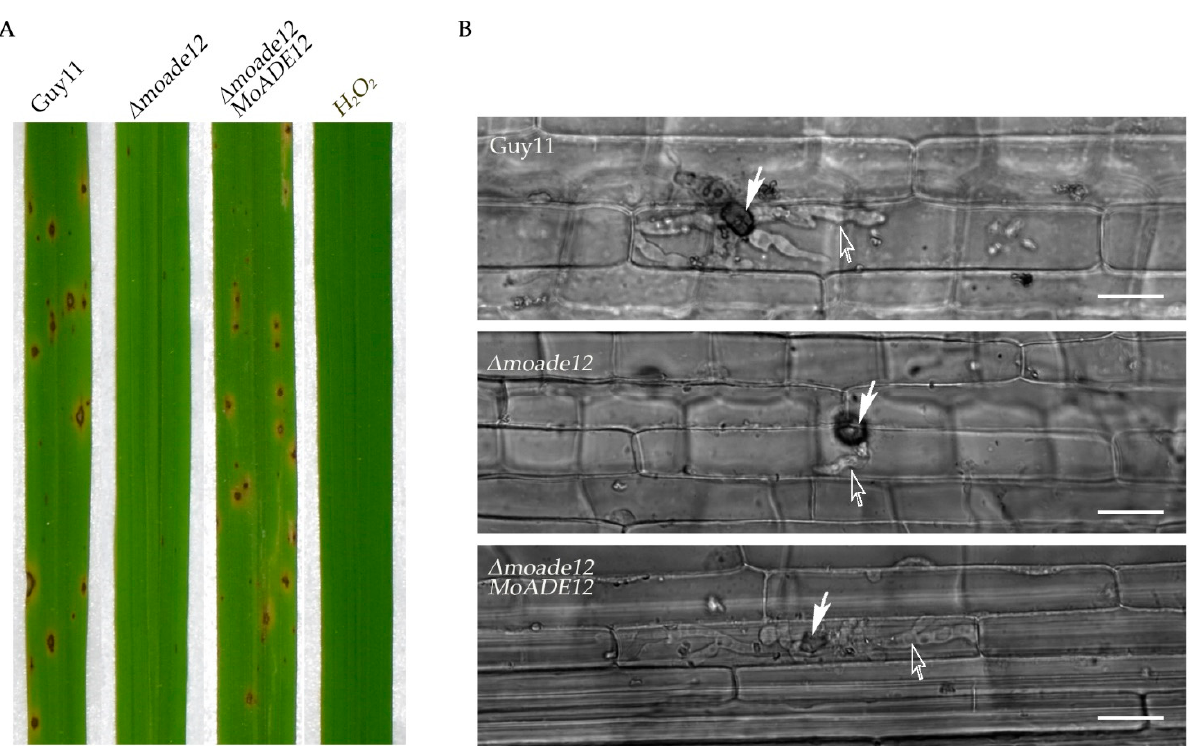
Figure 3. The Δ moade12 mutant attenuates virulence and infectious hyphal observation. ( A ) Conidial suspensions from the indicated strains were sprayed onto four-week-old rice seedlings and photographed at seven days post-inoculation. ( B ) The Δ moade12 mutant was defective in infectious hyphal growth. Appressorium is marked with the white solid arrow, and infectious hyphae is marked with the hollow white arrow. The white scale bar represents 20 µm.